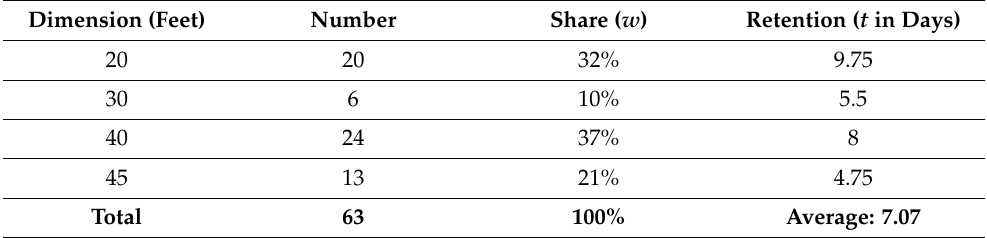
Table 2. Average daily number of inbound containers and their average retention time at the 11 European inland terminals, according to container